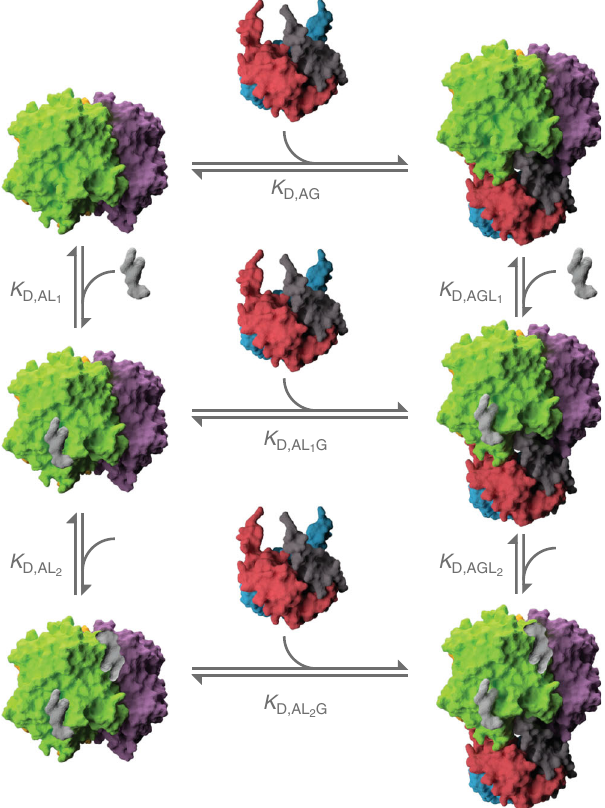
Fig. 3 Equilibrium-coupled-binding model for AmtB-binding GlnK and/or lipids. AmtB (green and purple), GlnK (red, blue, and gray), and representative phospholipid (silver) are included in the model. AmtB and GlnK are shown in surface representation (PDB 2NS1). ADP is not shown for